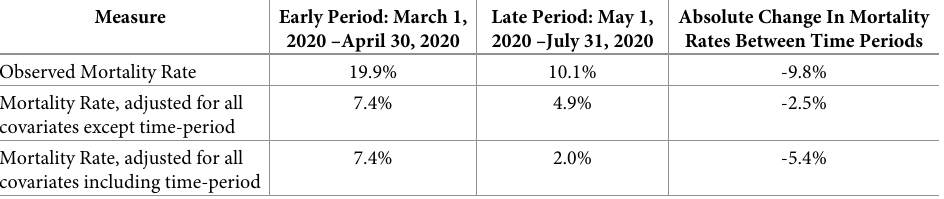
Table 4. Change in adjusted mortality between time